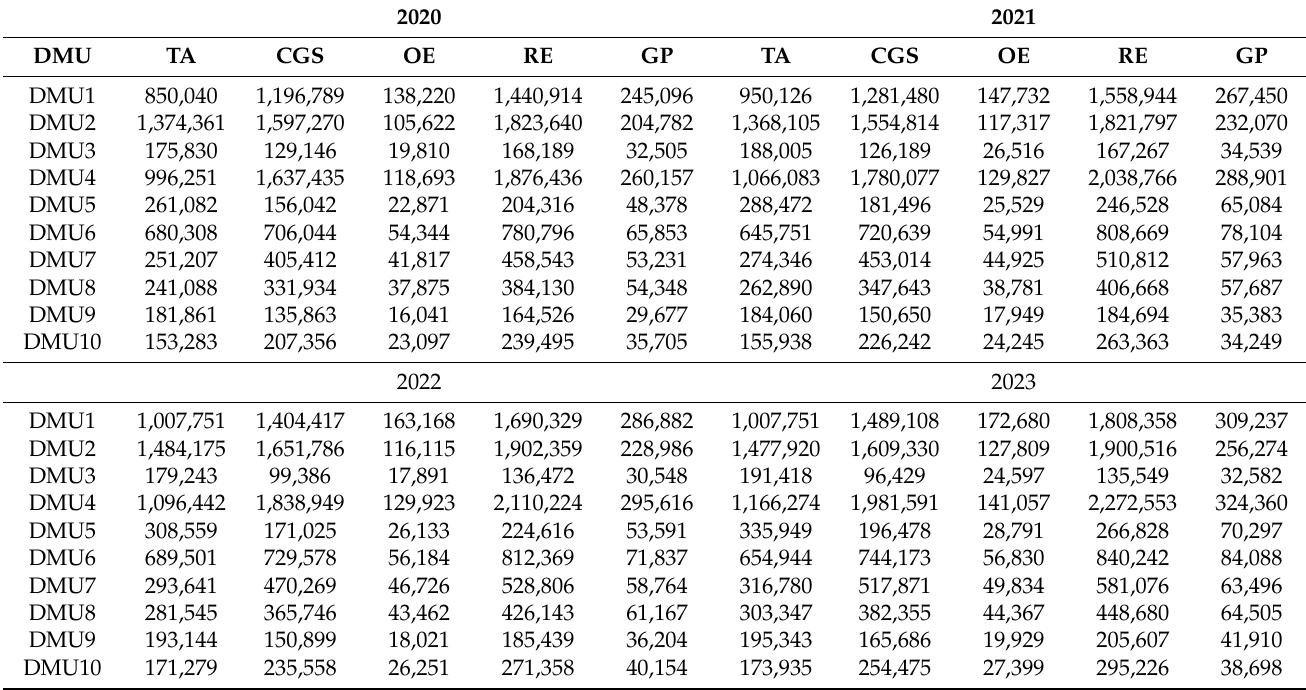
Table A2. Forecasting data of all DMUs from 2020 to